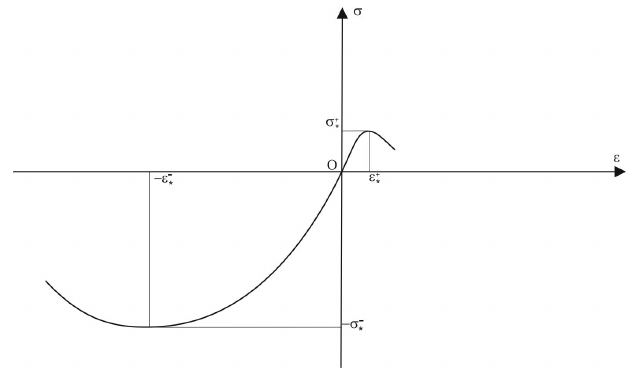
Figure 2. A tension-compression diagram of